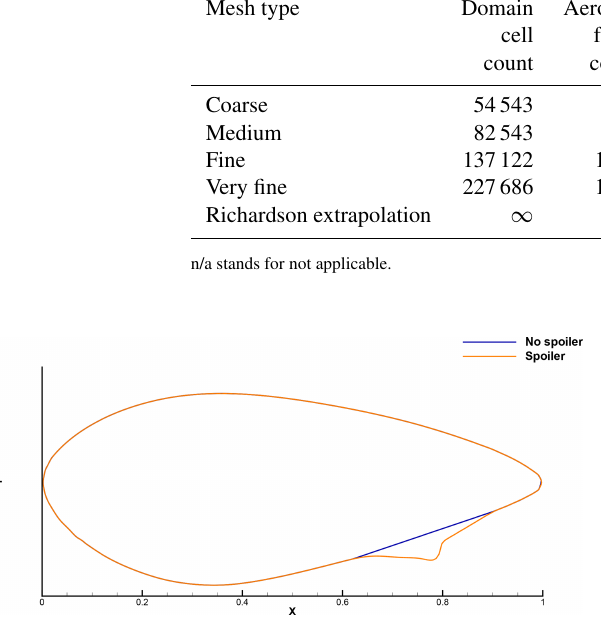
Figure 5. Comparison of the aerofoil shape with and without spoiler.